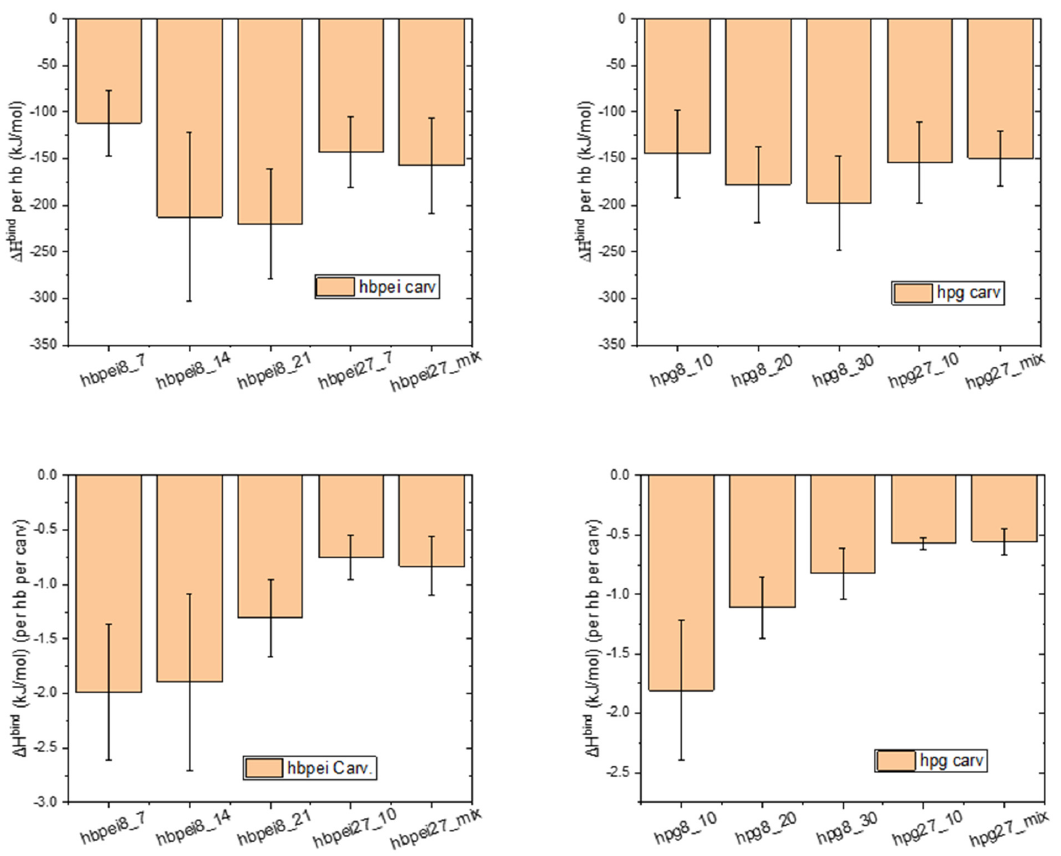
Figure 13. Binding enthalpy per hyperbranched molecule (hb) in the top panel and per hyperbranched molecule in the bottom panel.